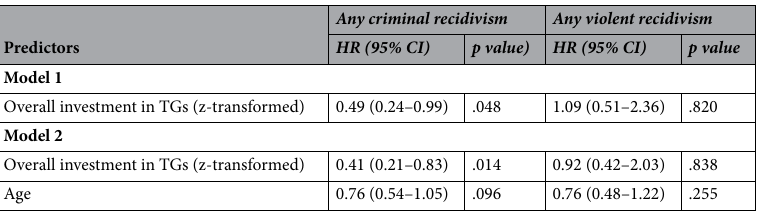
Table 4. Findings from univariate Cox-regressions with overall investments in TGs as predictors of violent recidivism and general recidivism in JO/CD subsample (n = 24). Note: male juveniles who committed serious violent offenses and met criteria of conduct disorder, HR = Hazard